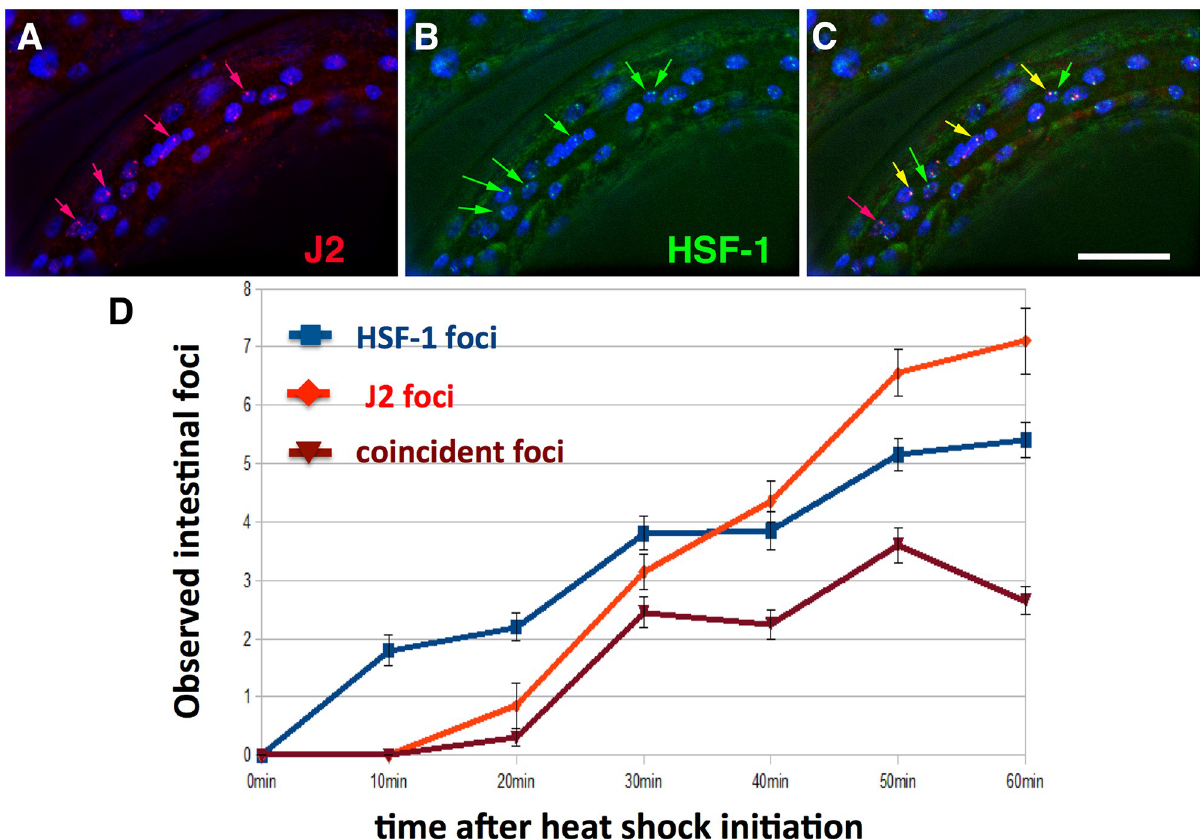
Fig 1. Heat shock induces nuclear foci detectable with dsRNA-specific antibody J2. Mid-animal intestinal region of 4th larval stage drSI13 worm fixed 40 minutes after heat shock at 35˚ C. (A) Nuclear J2 foci (red arrows). (B) HSF-1 foci (green arrows). (C) Overlap of J2 foci and HSF-1 foci (orange arrows). White size bar in bottom right corner (20 microns across). DNA stained with DAPI (blue). (D) Quantification of occurrence of HSF-1 and J2 foci over time. 19–20 worms scored per time point with 4 intestinal nuclei scored per worm.